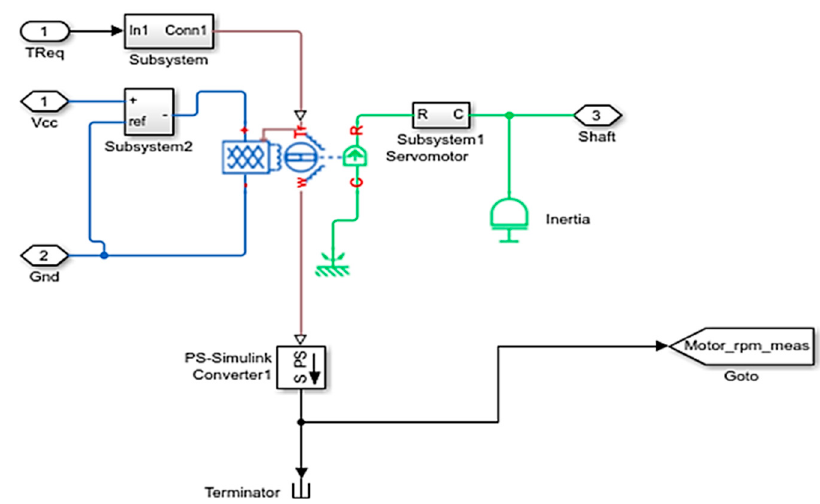
Figure 5. Starter model.